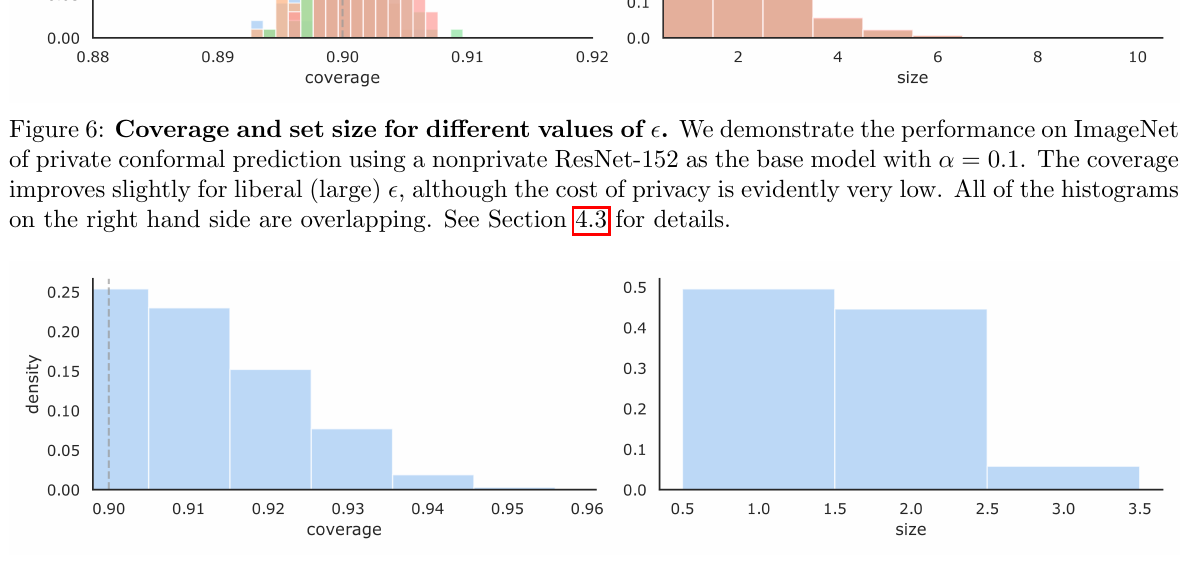
Figure 7: Coverage and set size on the CoronaHack data set. We demonstrate the performance on the CoronaHack data set of private conformal prediction using a nonprivate ResNet-18 as the base model with α = 0 . 1. The median coverage was 90 . 4%. See Section 4.4 for